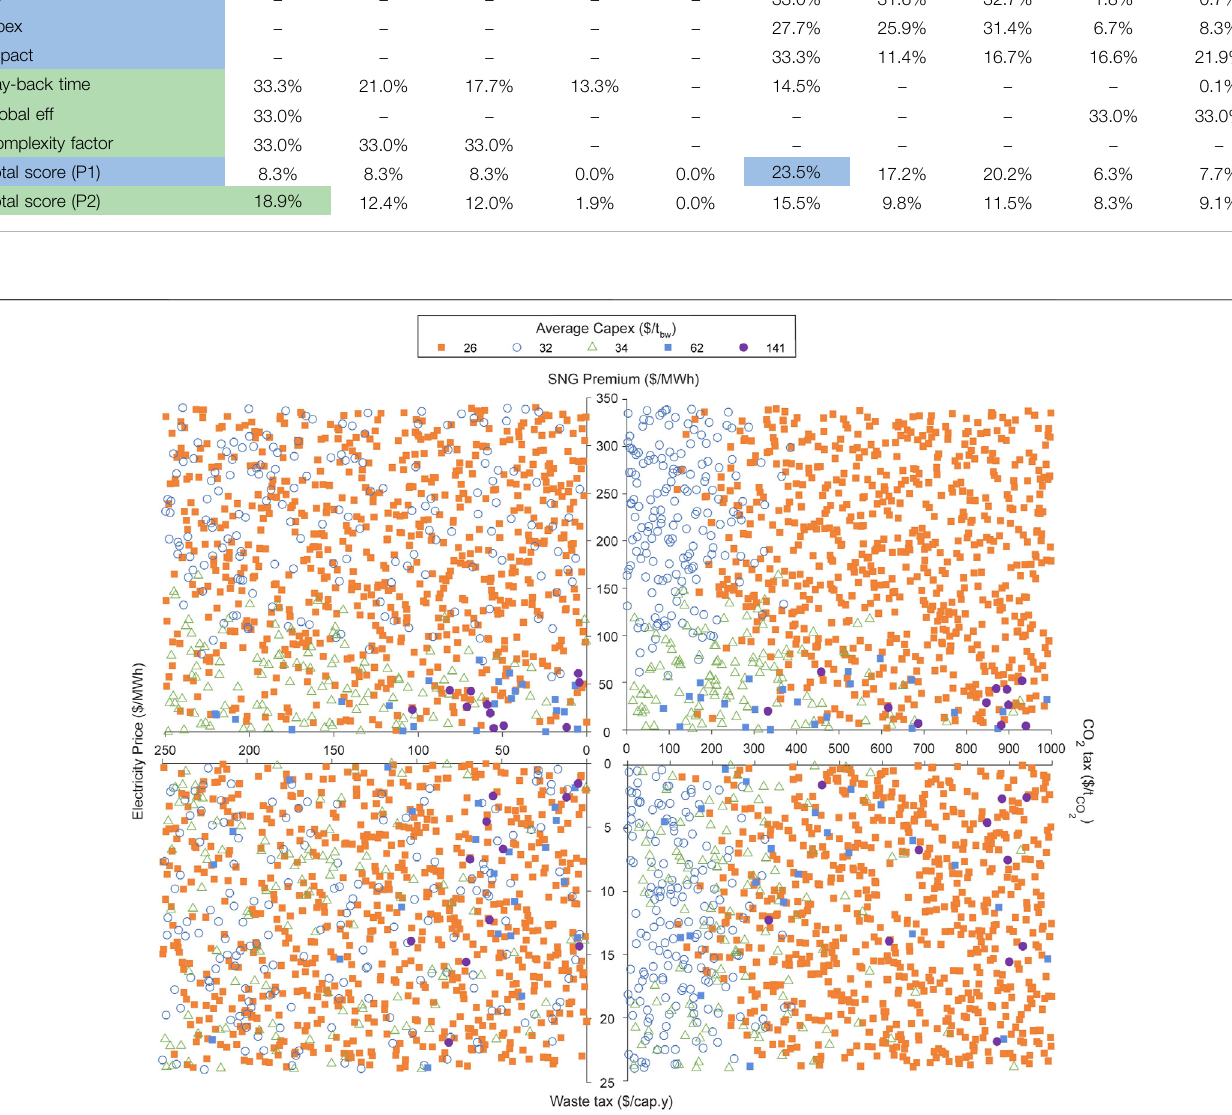
Frontiers in Energy Research |